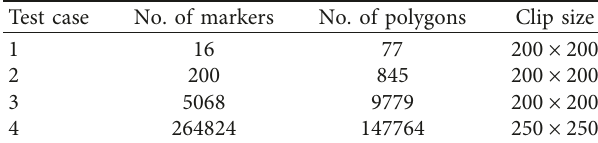
Table 1: Benchmarks from ICCAD